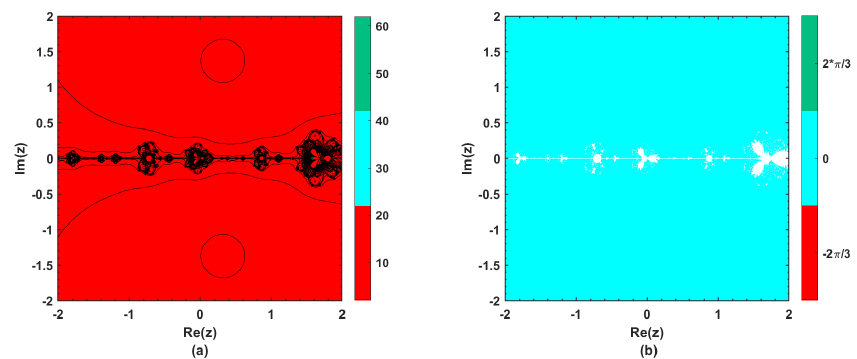
Figure 5. The polynomiographs obtained by the proposed method PS9 for P 5 ( z ) .